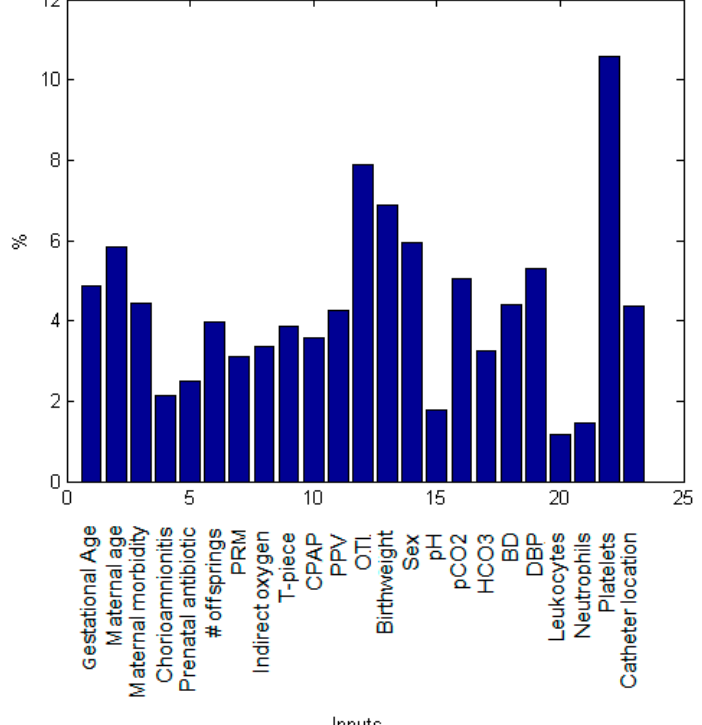
Figure 4. Relative contribution of each predictor variable to the estimation for the IP ANN model at birth. The relative influence histogram shows the mathematical importance of each predictor variable in the model evaluated by a sensitivity analysis. It is measured as a percentage of quantitative significance on the Y-axis for each predictor parameter at birth.